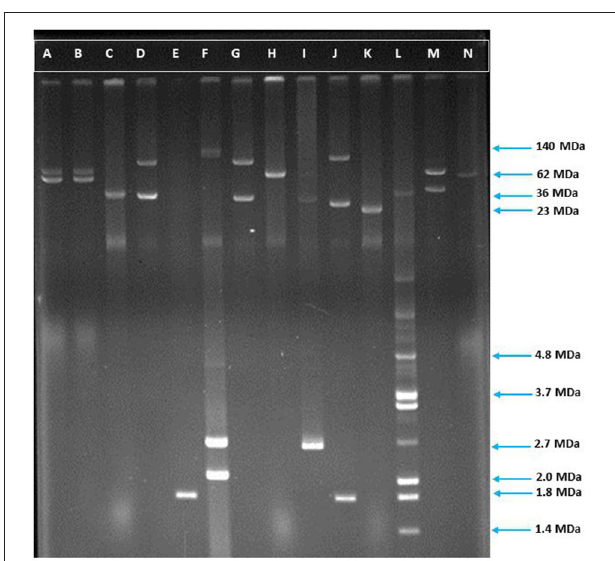
FIGURE 3 | Agarose gel electrophoresis of plasmid DNA showing the patterns among the ESBL positive isolates. Lane-C: RP4 (36 MDa), Lane-F: E. coli strain PDK9 (140, 105, 2.7, 2.1 MDa), Lane-H: R1 (62 MDa), Lane-K: Sa (23 MDa), Lane-L: V517 (35.8, 3.4, 3.7, 2.0, 1.8, 1.4), Lane-A, B, D, E, G, I, J, M, and N are ESBL positive E. coli . The molecular weight of the markers is shown in the picture.